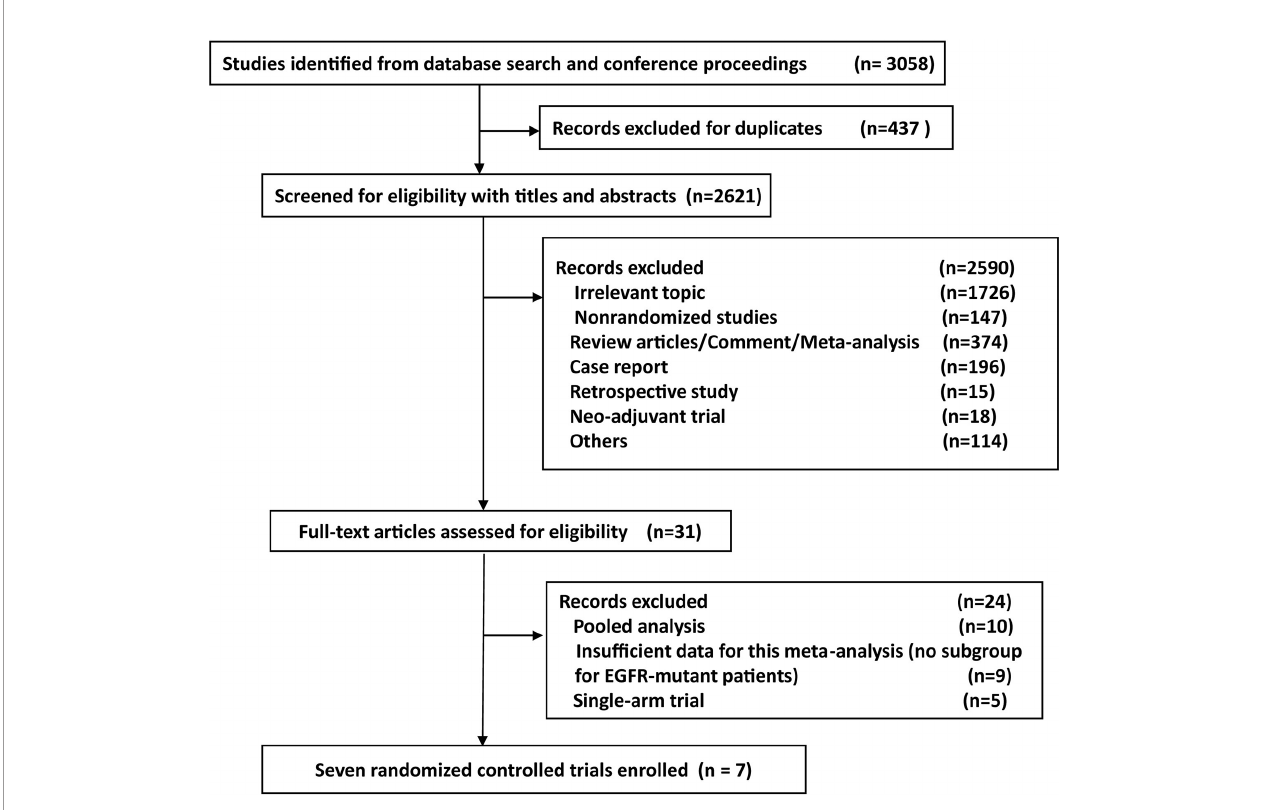
FIGURE 1 | The fl owchart of study selection process for the